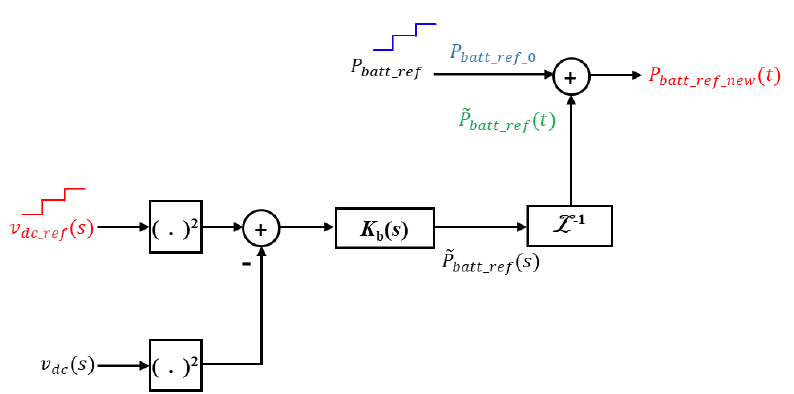
Figure 10. Control Block Diagram of the Output Power on Battery for the DC Link Voltage Fluctuation Control.